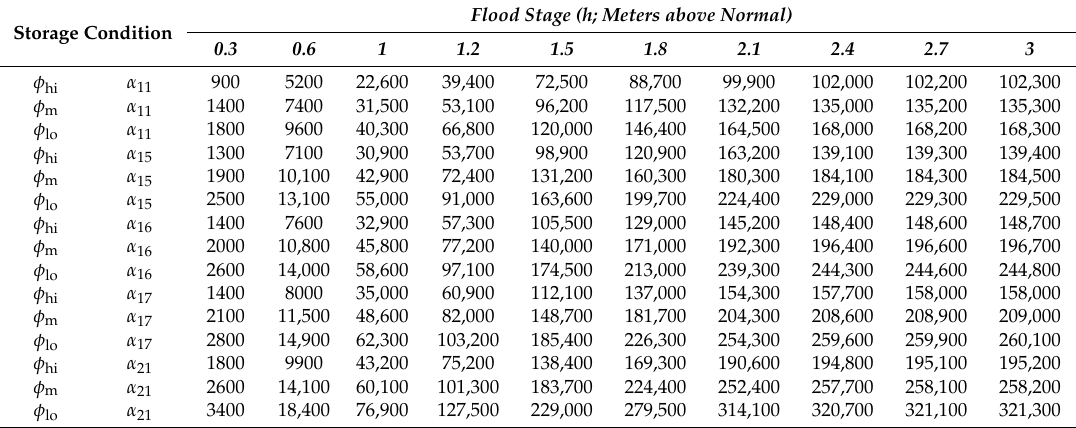
Table 2. Site storage potentials (m 3 ) for eight different conditions: high ( φ hi ), low ( φ lo ), and middle ( φ m ) Table conditions and respective storage potentials are sorted in ascending order of storage